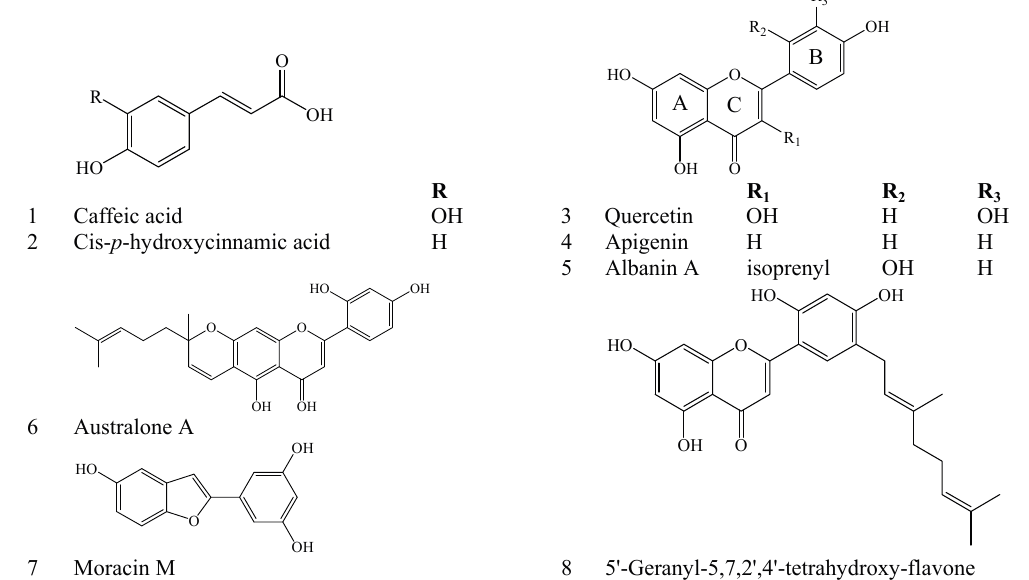
Figure 1. Phenolic compounds isolated from EtoAc extract of sugarcane tops.